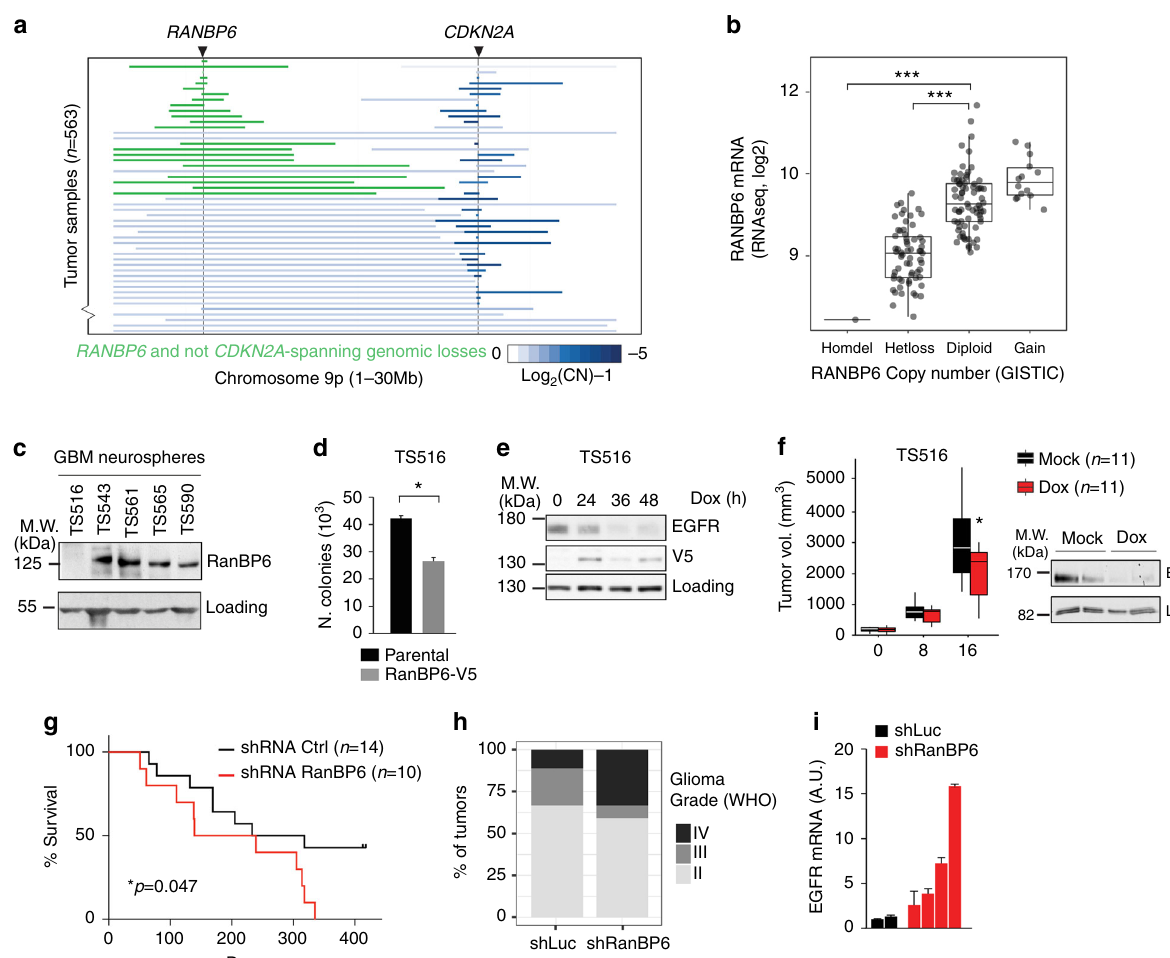
Fig. 6 RanBP6 suppresses growth factor output and glioma growth. a Focal deletions of the RANBP6 (left) and CDKN2A (right) loci in GBM. b Relationship between RANBP6 copy number and mRNA levels in GBM ( n = 151); Tukey ’ s honest signi fi cant difference: *** p < 0.001. c RanBP6 protein levels in a panel of established patient-derived GBM tumor spheres. The immunoblots of whole-cell lysates are shown. d Ectopic expression of RanBP6-V5 in RanBP6-low TS516 GBM neurosphere reduces anchorage-independent growth. e Ectopic expression of RanBP6-V5 reduces EGFR protein levels in a time-dependent manner. f RanBP6 overexpression reduces tumor growth (left panel) and EGFR expression in a TS516 xenograft model (right panel). Student ’ s t test: * p < 0.05. g RanBP6 KD reduces survival in RCAS-tva mouse glioma model. Kaplan – Meier survival curves of PDGFB-induced gliomas generated